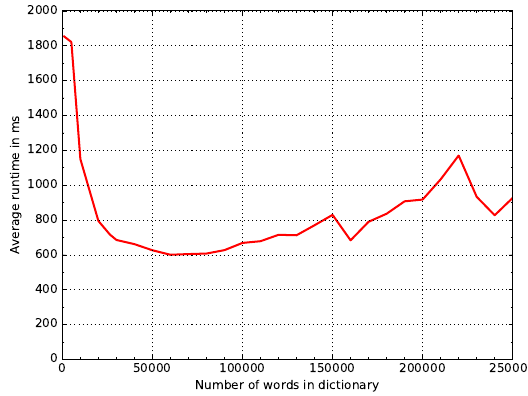
Figure 6. Influence of the dictionary size on the runtime